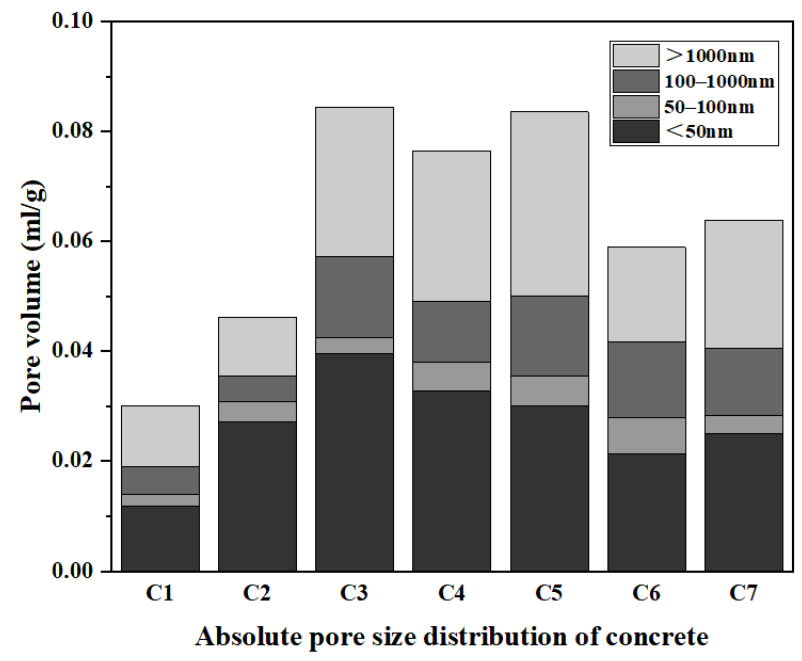
Figure 6. Size distribution of pore groups in concrete.